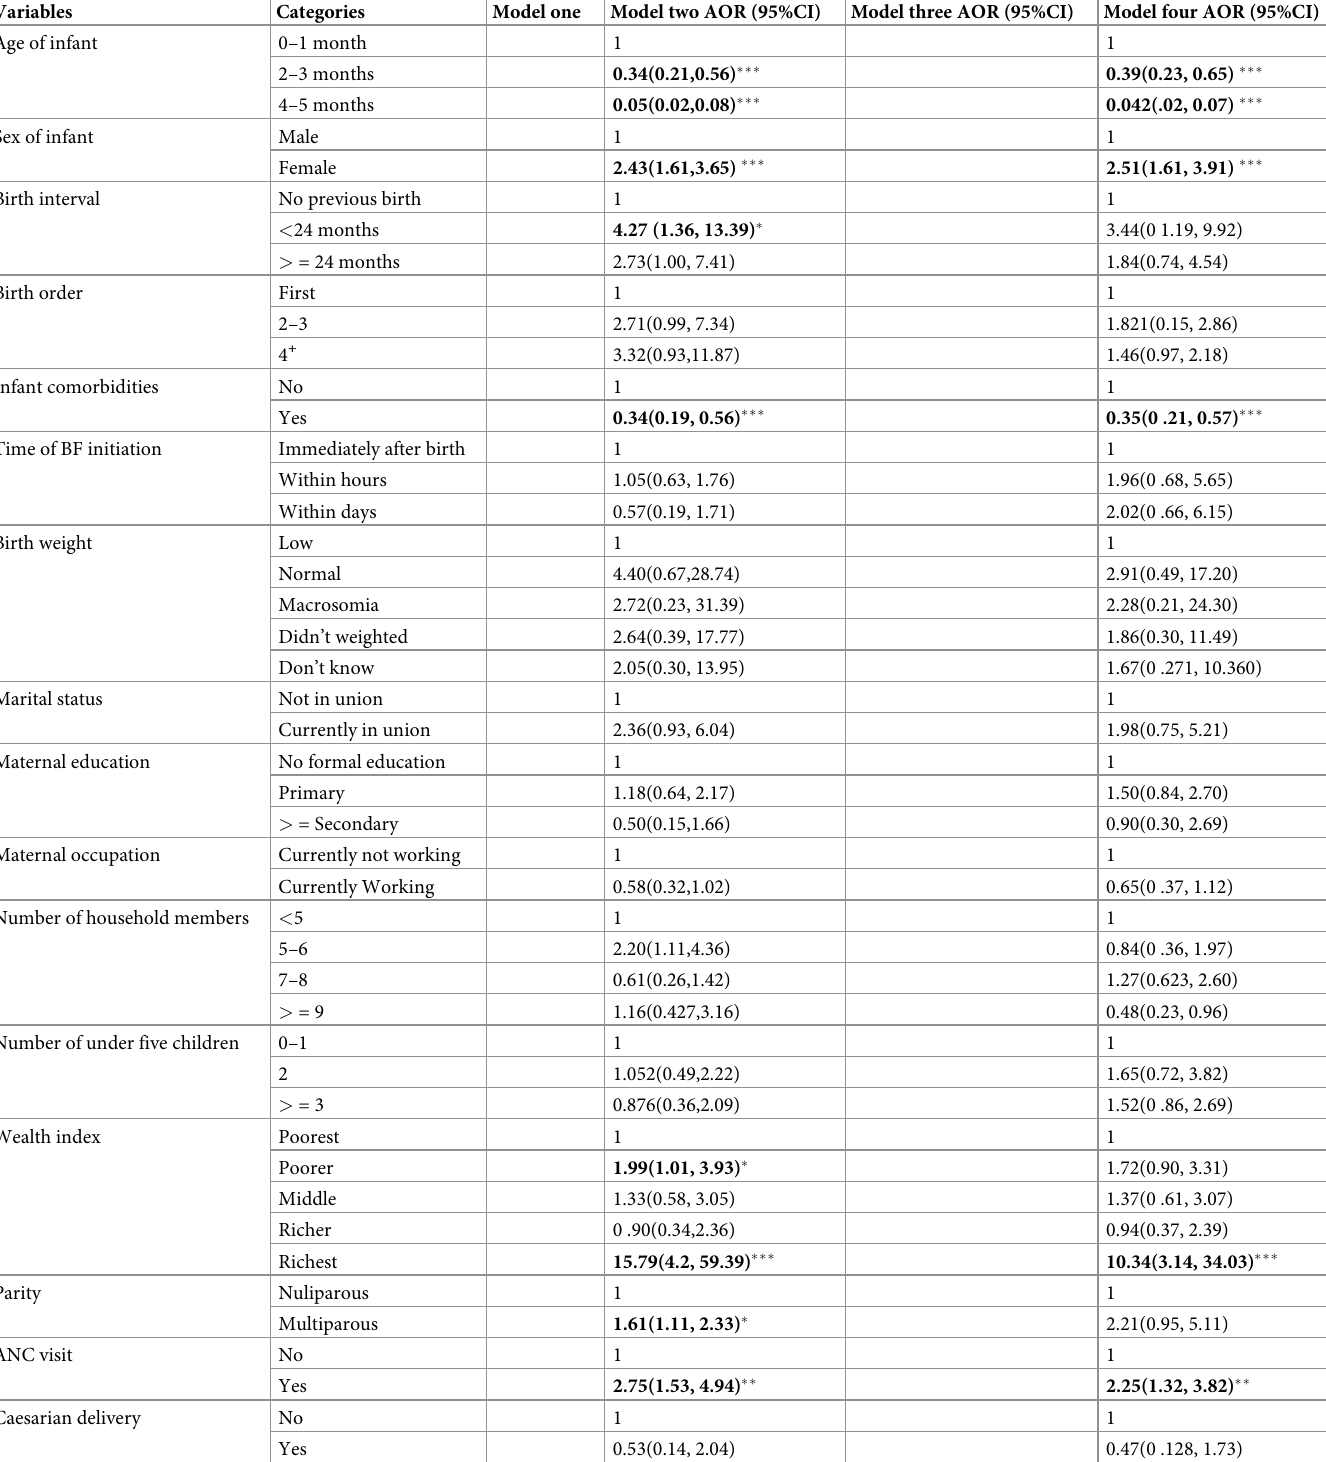
Table 5. Multilevel logistic regression analysis of both individual and community level factors associated with exclusive breastfeeding among infants under 6 months of age in Ethiopia, 2016 (N =